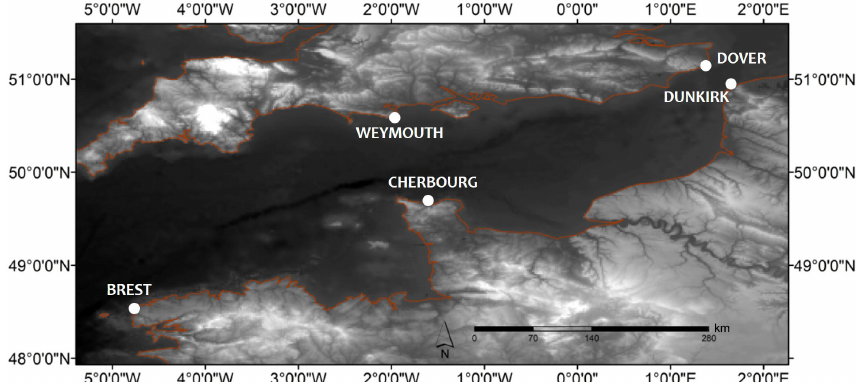
Figure 1. Geographical location of the study area and the different tide gauges along the English Channel coasts: Brest, Cherbourg and Dunkirk (NW France) and Dover and Weymouth (SW